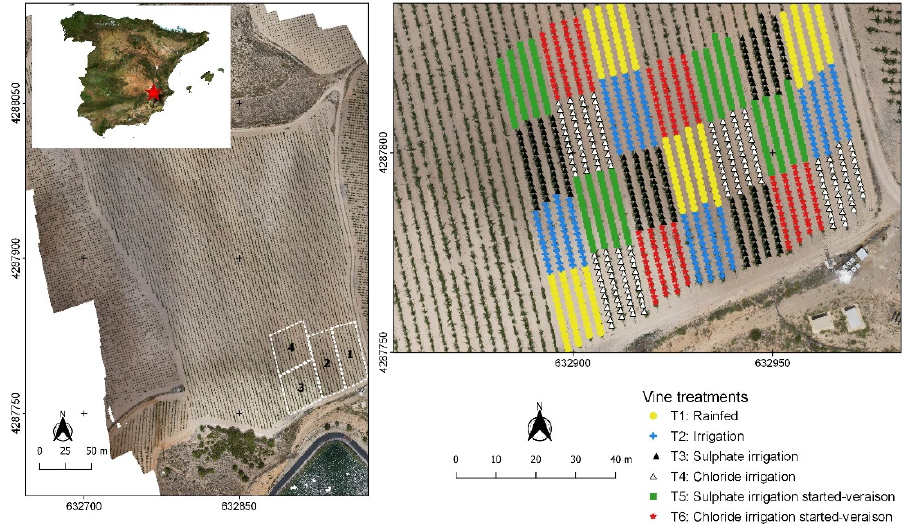
Figure 2. Location of the commercial vineyard in south-eastern Spain, and the distribution of experimental units in 2018, 2019, and 2020. In the lefthand image, the white dashed line outlines the blocks of the experiment (four blocks). In the righthand image, each symbol corresponds to a grapevine plant. Table 1. Annual and growing season (from April to the end of September) rainfall and reference evapotranspiration (ET 0 ) values from the studied vineyard cv. Monastrell located in south-eastern Spain.